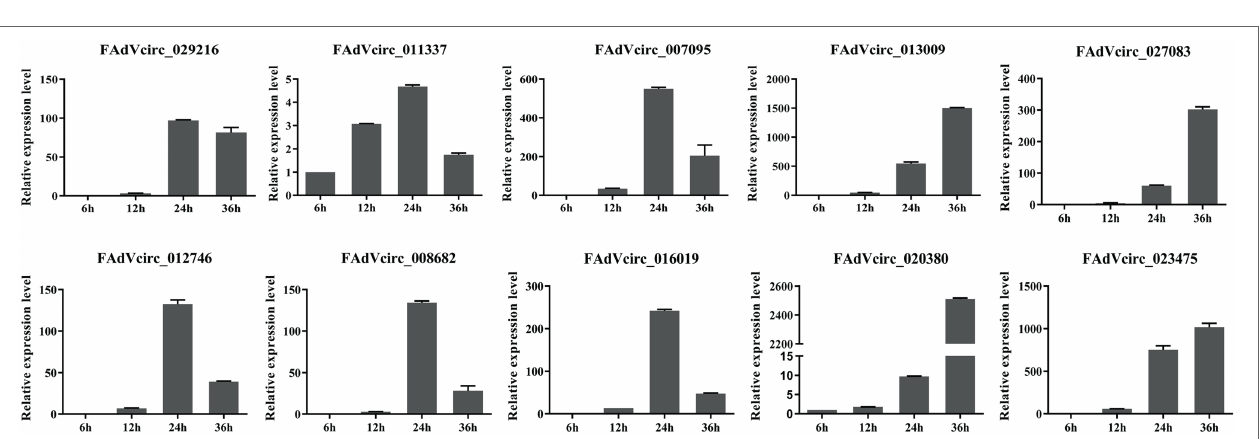
FIGURE 8 | The expression levels of FAdVcircRNAs in LMH cells infected with FAdV-4 at different times. Ten FAdVcircRNAs (FAdVcirc_029216, FAdVcirc_011337, FAdVcirc_007095, FAdVcirc_013009, FAdVcirc_027083, FAdVcirc_012746, FAdVcirc_008682, FAdVcirc_016019, and FAdVcirc_020380, FAdVcirc_023475) were detected in LMH cells infected with FAdV-4 at 6, 12, 24, and 36